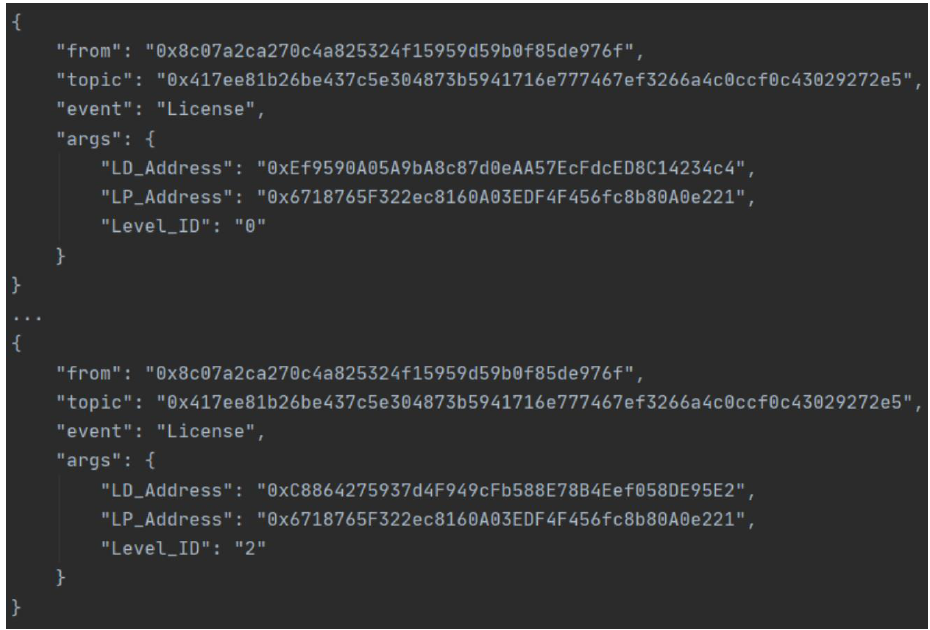
Figure 6. The data formart of the license recorded in the